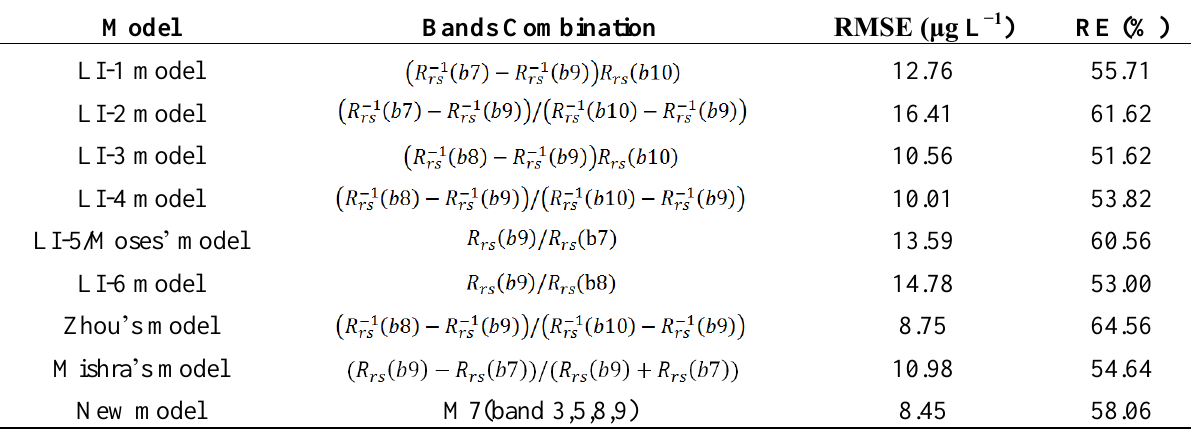
Table 4. Comparison of nine models with MERIS